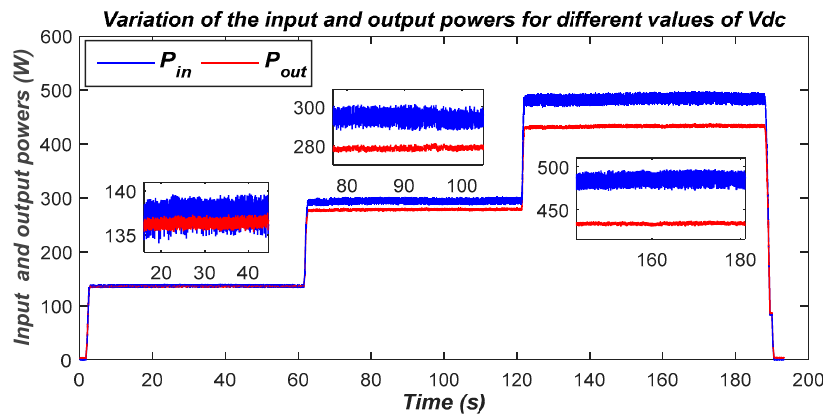
Figure 28. Battery-charging current variations.